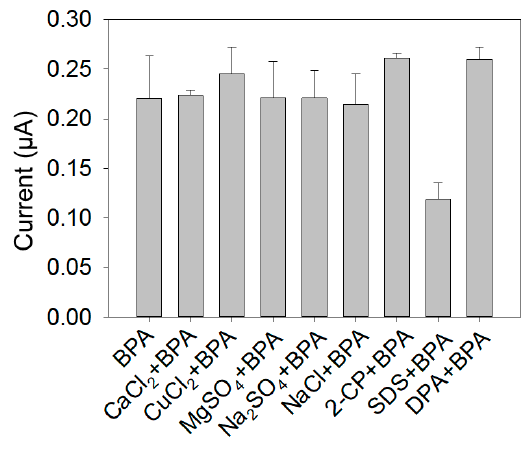
Figure 7. Specificity of the BCNPs/Tyr/Nafion/GCE biosensor for detection of BPA (3 µ M) in 50 mM PB (PH = 7.0), where other irrelevant compounds coexist individually including 3 mM of CaCl 2 , CuCl 2 , MgSO 4 , Na 2 SO 4 , NaCl, 2-CP, SDS and DPA.